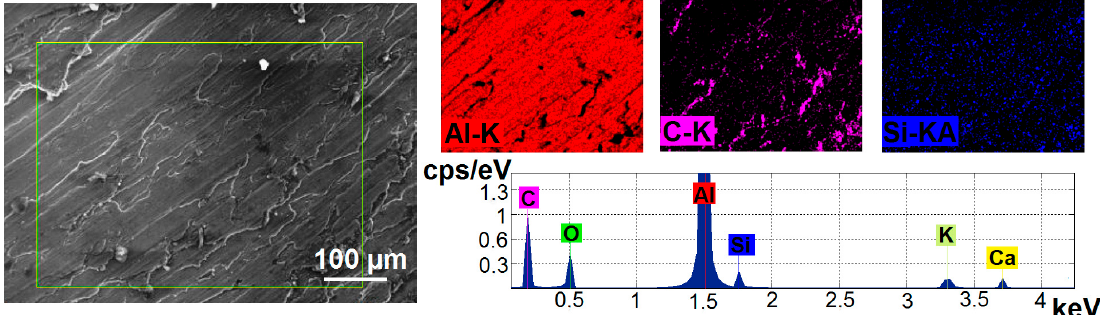
Figure 4. SEM image, EDS microanalysis and chemical mapping of the elements Al, C and Si of the surface of the composite material GNS/AA1050 obtained via FSP.